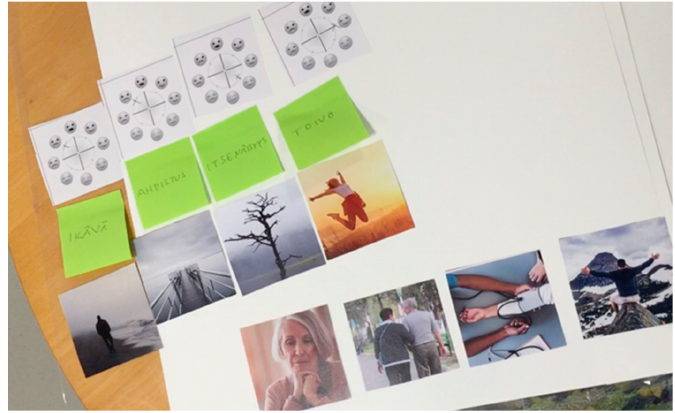
Figure 5. An example of the final selection made at an Age Workshop.